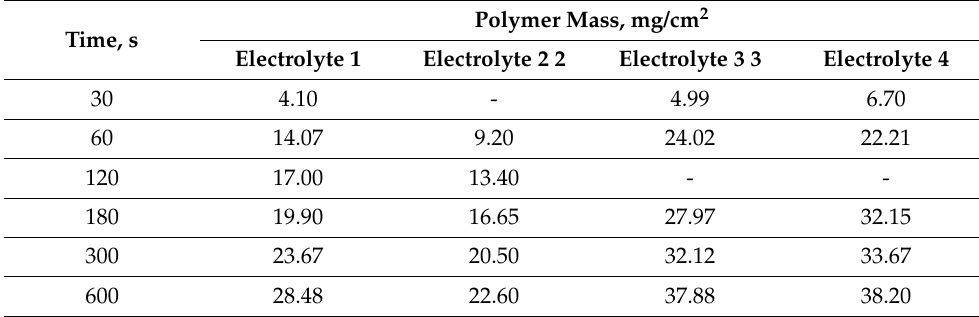
Table 3. Dependence of the polymer weight on the time of composite formation.